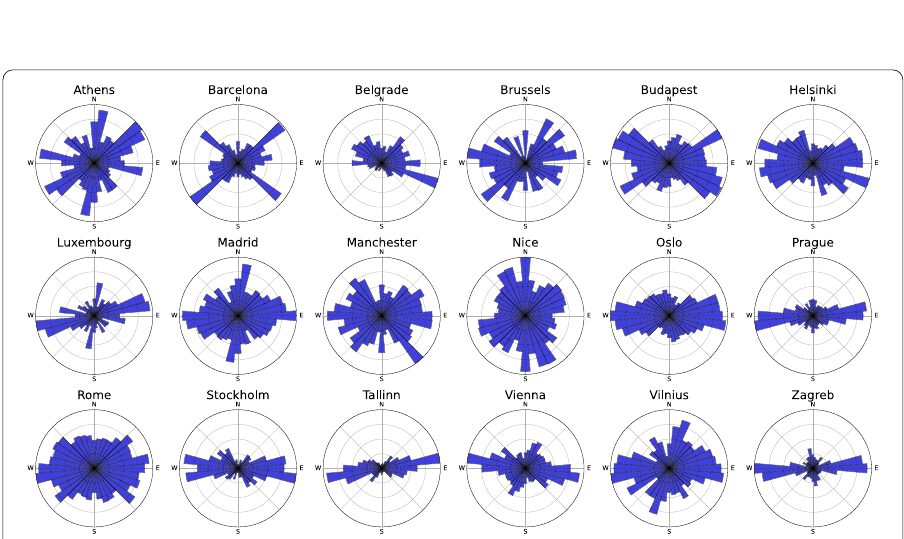
Fig. 5 Public transport network orientations of 18 selected European cities for which valid GTFS data could be obtained via https:// trans itfee ds. com/l/ 60-